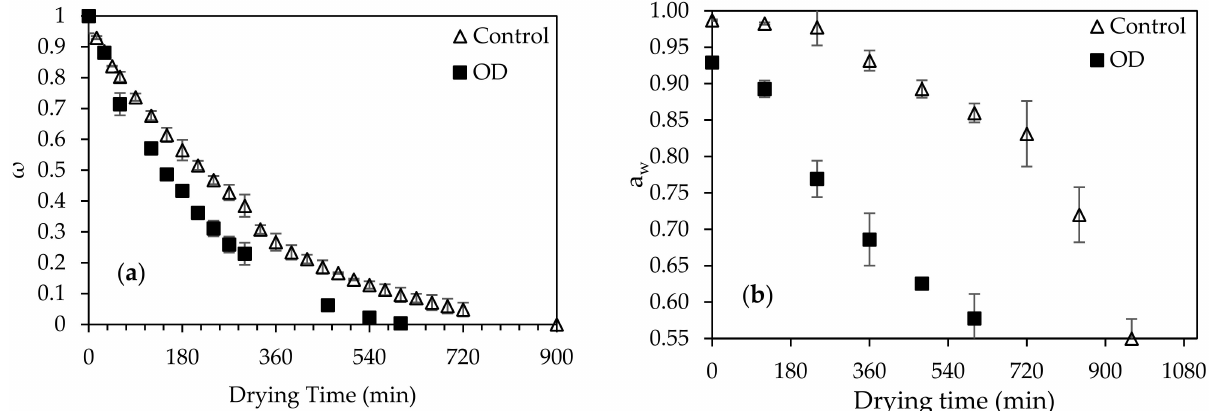
Figure 4. Effect of air-drying at 70 ◦ C on the ( a ) non-dimensional moisture content ω and ( b ) water activity a w , of the OD pretreated (45 ◦ C, 90 min, 1/4 ratio of sample per OD solution ( w s / w OD )) ( (cid:4) ) and untreated (Control) ( (cid:52) ) figs. Error bars represent standard deviation from multiple replications of